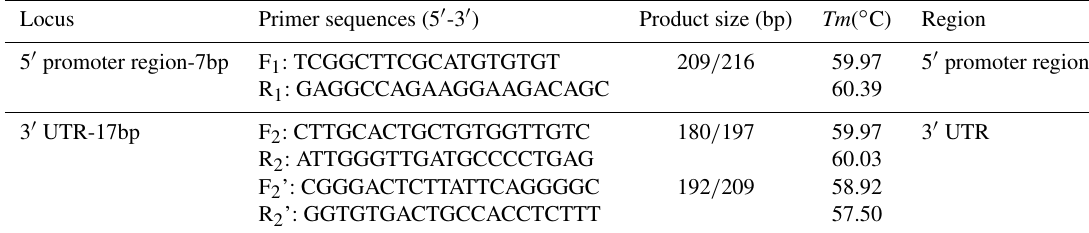
Table 1. PCR primer sequences of the sheep SIRT7 gene for amplification. Locus Primer sequences (5 (cid:48) -3 (cid:48)